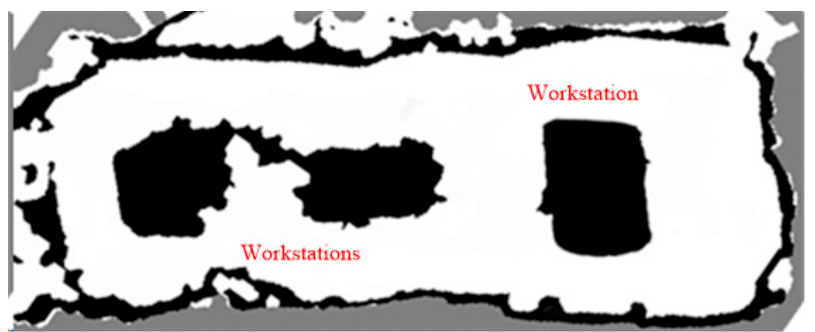
Figure 9. The obtained map of Area 2.